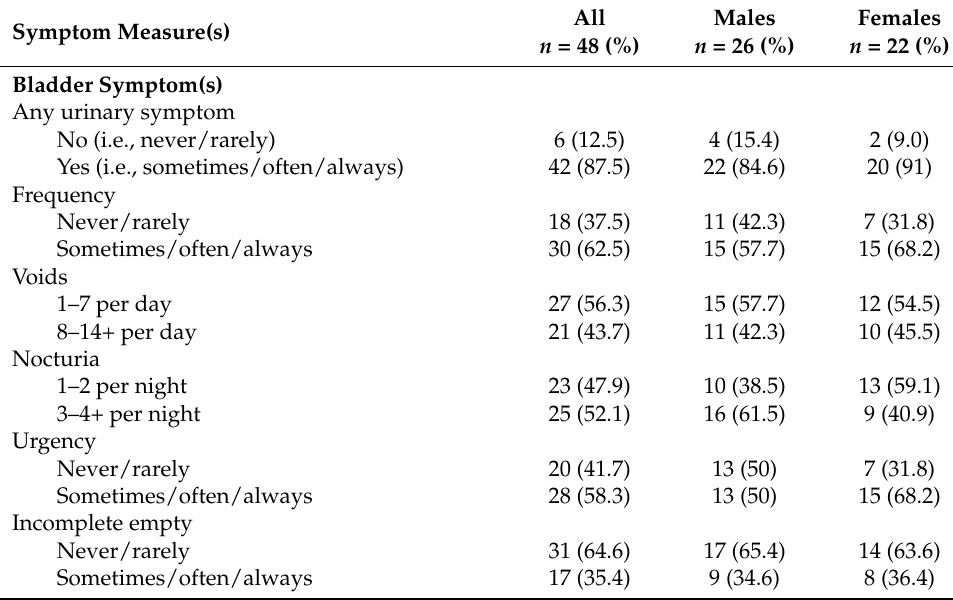
Table 3. Bladder, lower bowel, and sexual symptoms stratified by